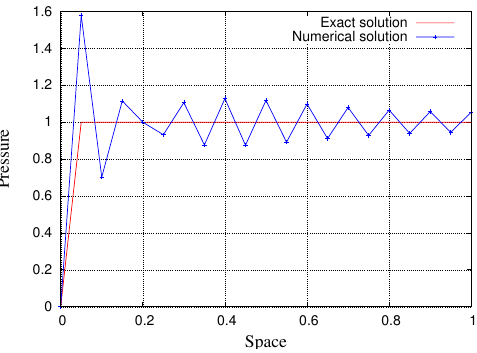
Figure 6. Comparison between an accurate enough approximation of the analytical solution and an approximated solution for pressure obtained by scheme (2.7) for the column problem at time T = 0 . 001 and N = M =